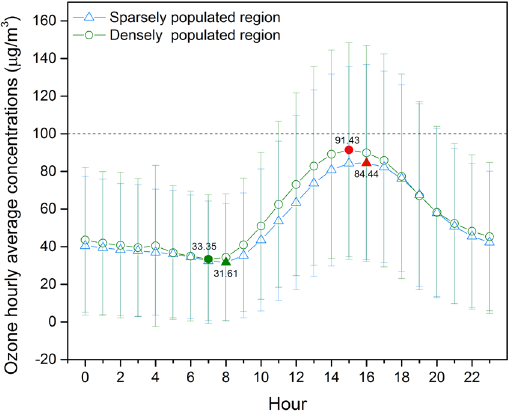
Figure 3. Hourly distribution of three-year averaged ground-level ozone concentrations during 2013–2015.